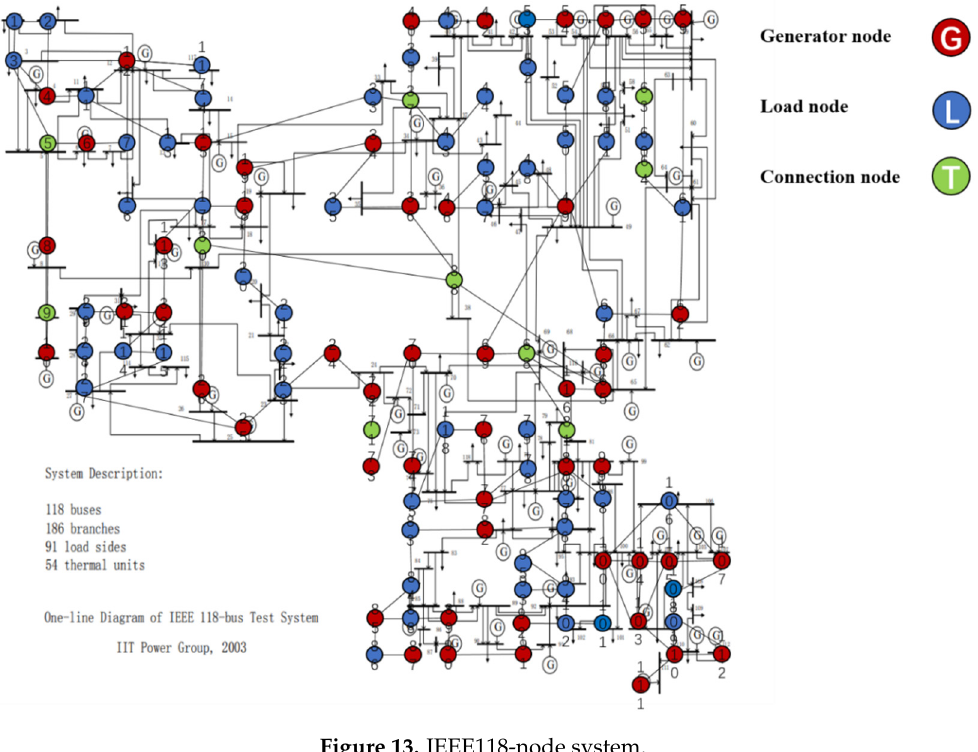
Figure 13. IEEE118-node system.